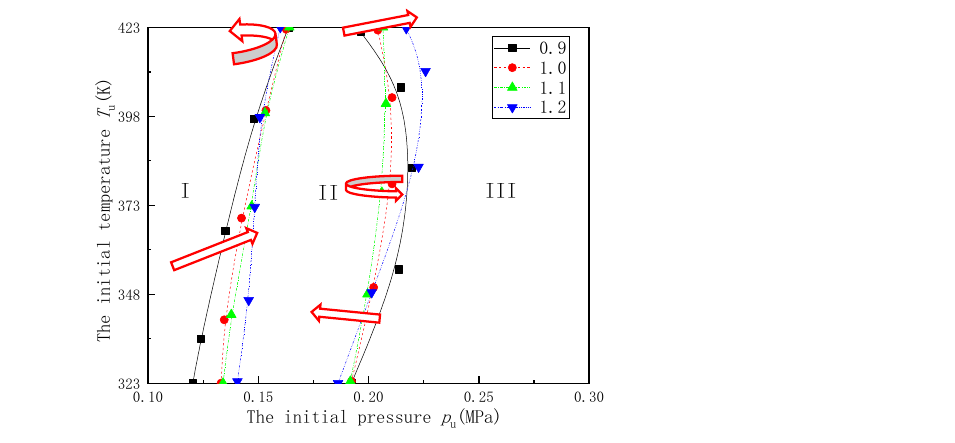
Figure 7. Variation pattern of the equal weight curve corresponding to Φ with ∆T = 25 K and ∆P = 0.05 MPa.